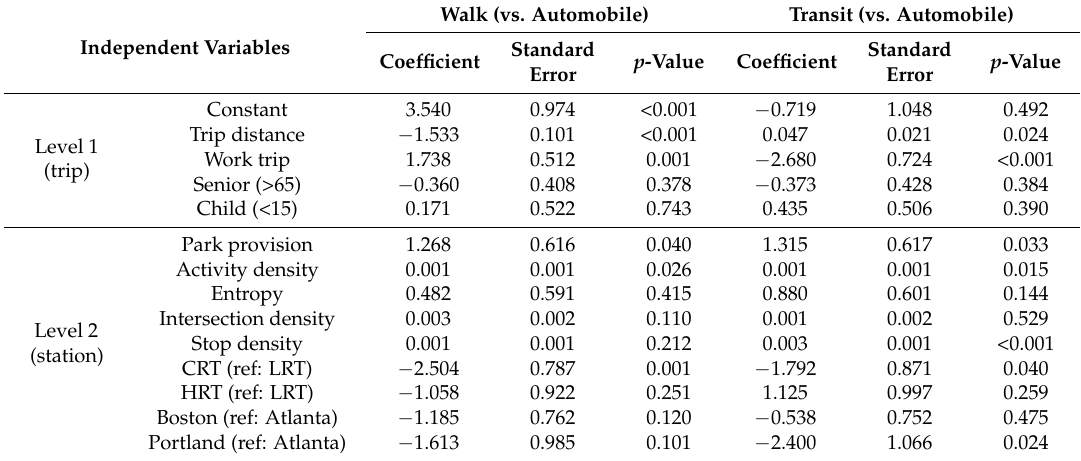
Table 3. A multilevel multinomial logistic regression model of log-odds of a walking trip or a transit trip. Walk (vs. Independent Variables